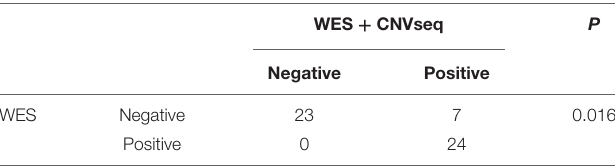
TABLE 3 | A combination of WES and CNVseq was significantly effective than WES in patients with rare neurological disorders.